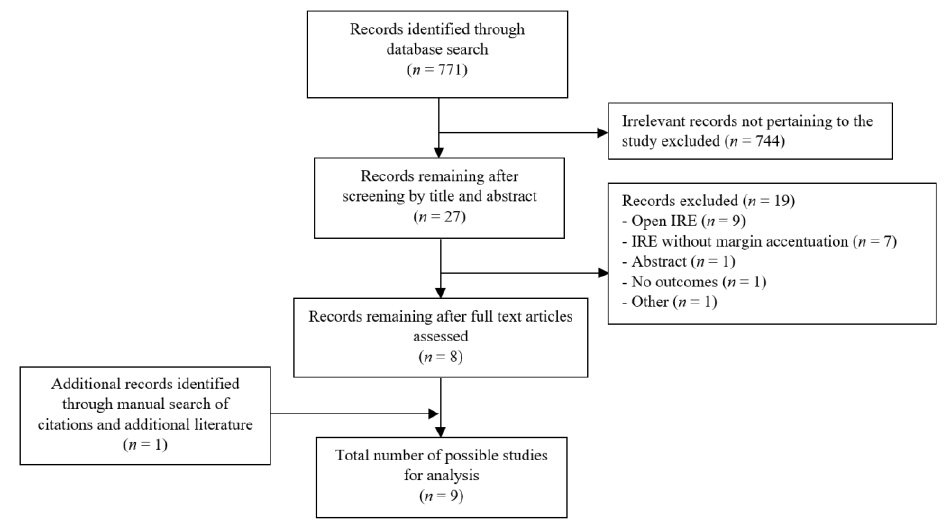
Figure 1. PRISMA flow chart of literature search strategy. Table 1. Study characteristics of all articles reporting on margin accentuation irreversible electroporation for locally advanced pancreatic cancer.